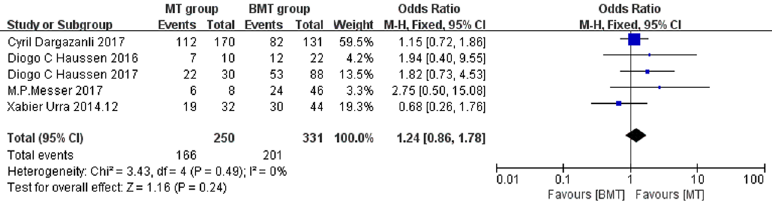
Fig 3. Forest plots of excellent outcomes. Forest plots showing the odds ratios of excellent outcomes (90-day mRS of 0–1) in the patients treated with MT vs. those treated with